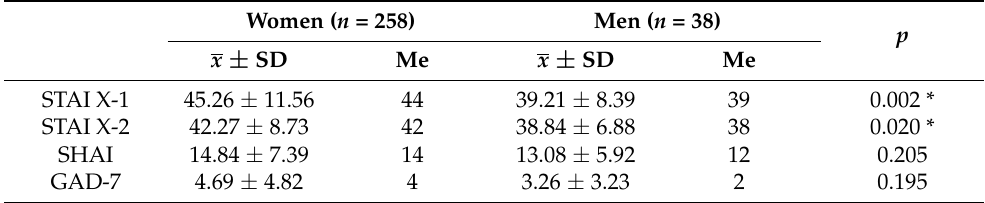
Table 4. Impact of sex on the scores obtained in the psychometric scales applied in the